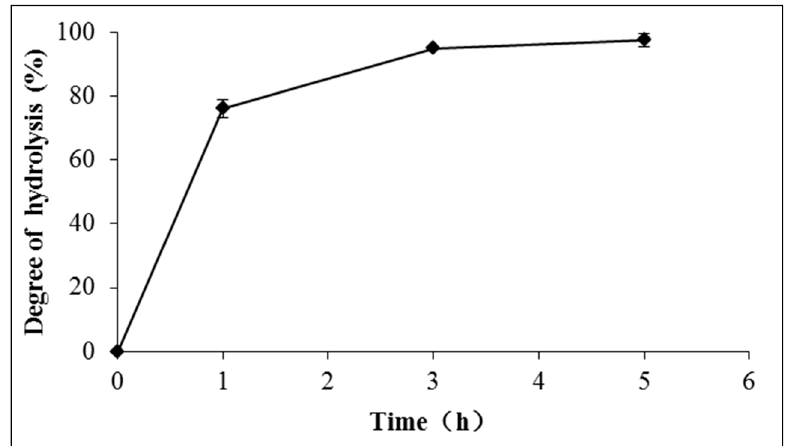
Figure 5. The effect of the reaction time on the hydrolysis of Schizochytrium sp . oil. Conditions: Temperature 220 °C, pressure 2.8 Mpa, water to oil ratio = 10:1 (w:w), 150 rpm.